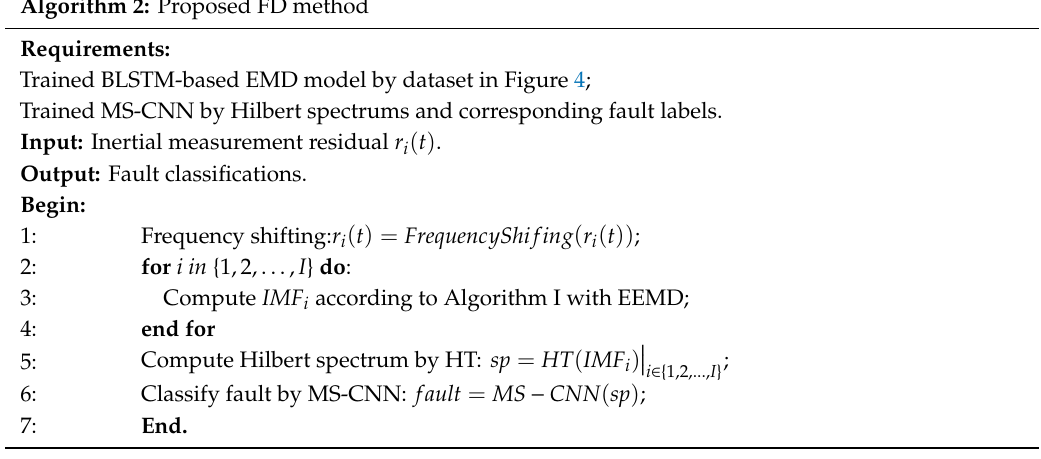
Algorithm 2: Proposed FD